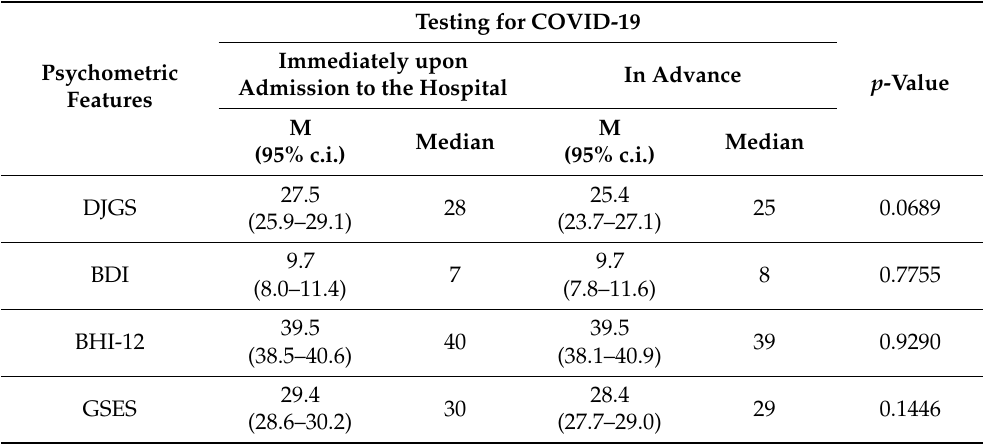
Table 8. Correlations between the psychometric scales used and the place where the COVID-19 test was